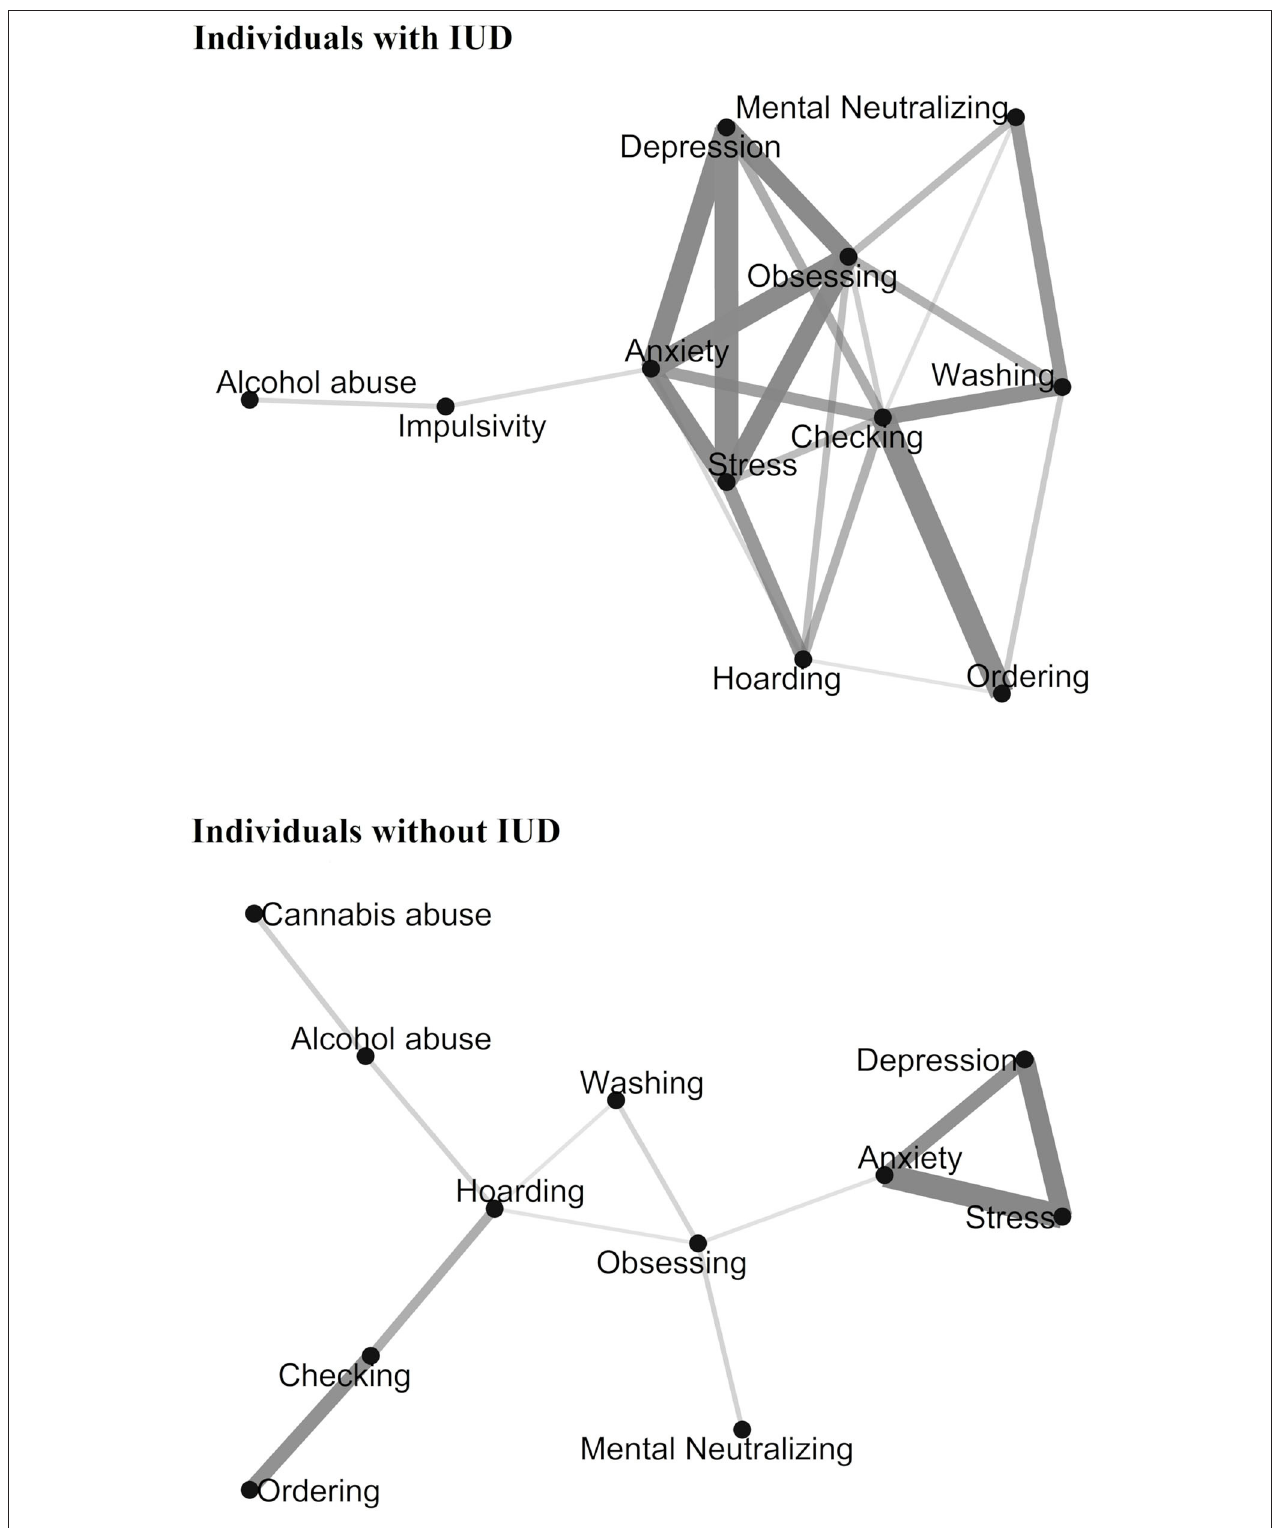
FIGURE 3 | Correlation network plot for individuals with mild to moderate Internet Use Disorder (IUD) and controls. Only Pearson’s rs ≥ |0.30| were included. Variables that are more strongly correlated appear closer together and are connected by stronger paths. The proximity of the points is determined using multidimensional